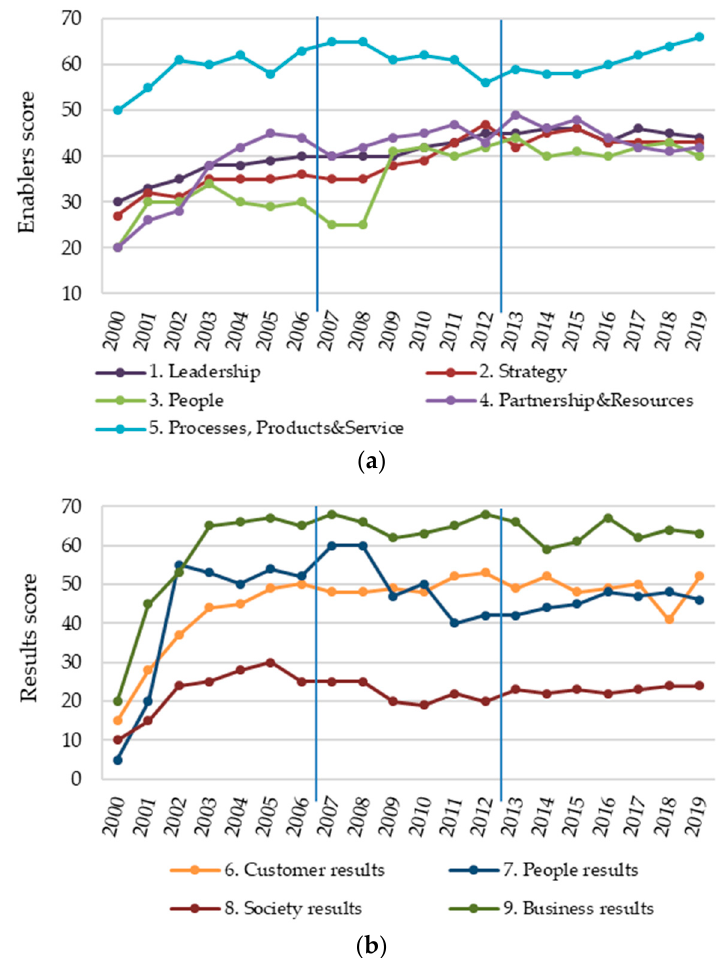
Figure 3. Decomposed Level of Excellence for: ( a ) enablers criteria; ( b ) results criteria.